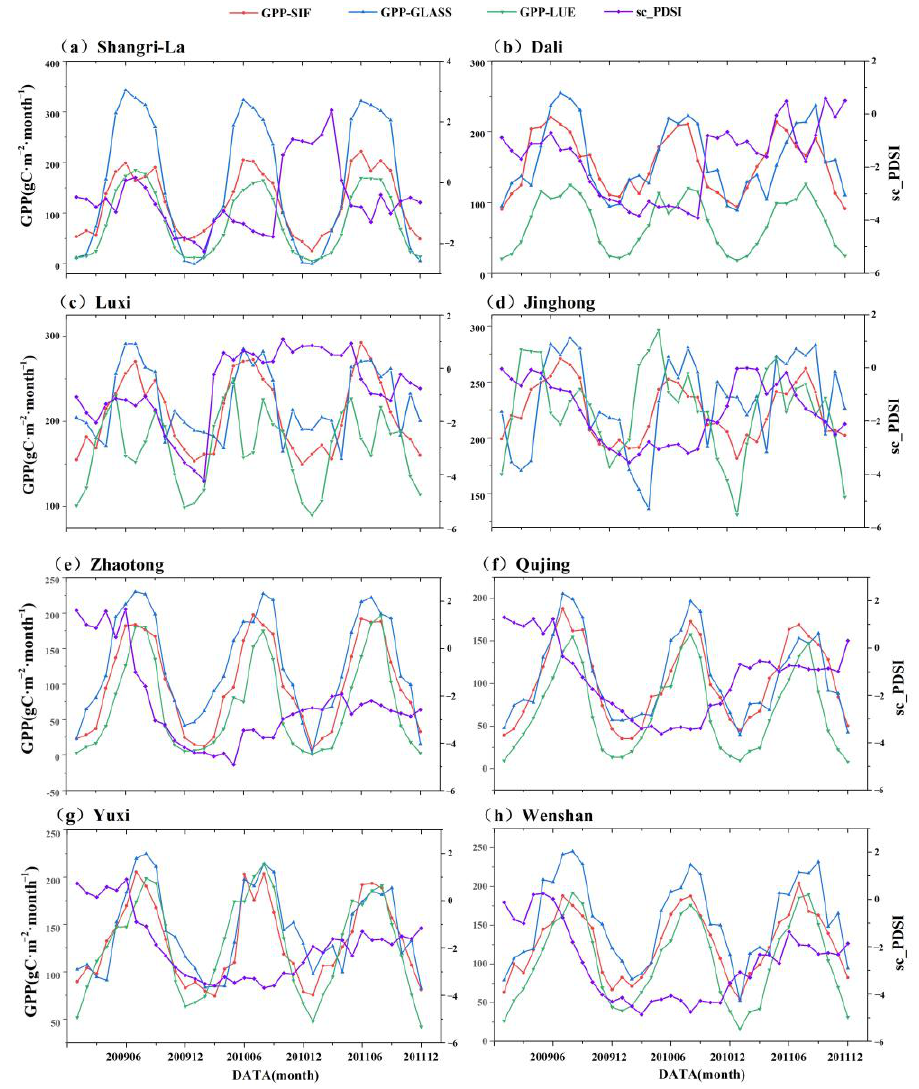
Figure 11. Changes in the three types of GPP and sc_PDSI in Yunnan Province, 2009 – 2011.